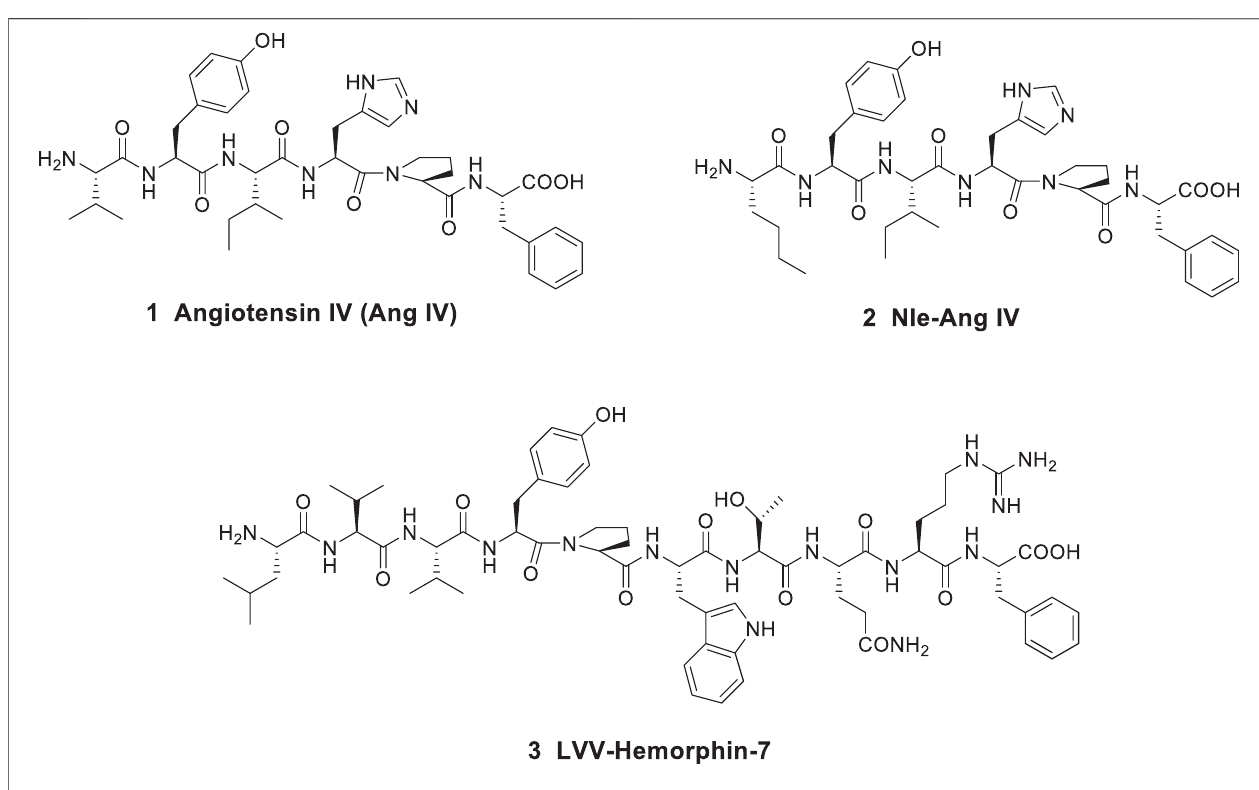
Figure 1 | Peptides with high af fi nity to the angiotensin IV (AT4) receptor.